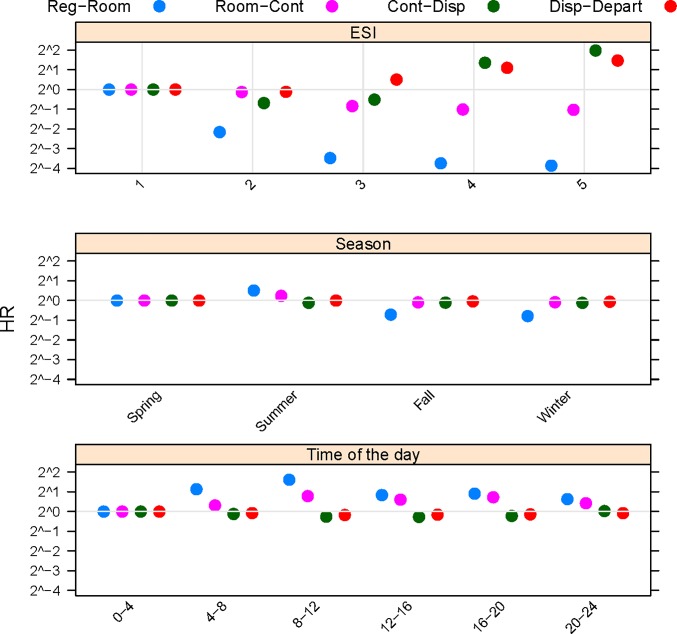
Forest plot of hazard ratios for ESI (acuity), season, and time of day (in hours).Hazard ratios are for transitions from Registration to Room (Reg-Room), Room to First Physician Contact (Room-Cont), First Physician Contact to Disposition (Cont-Disp), and Disposition to Departure (Disp-Depart).